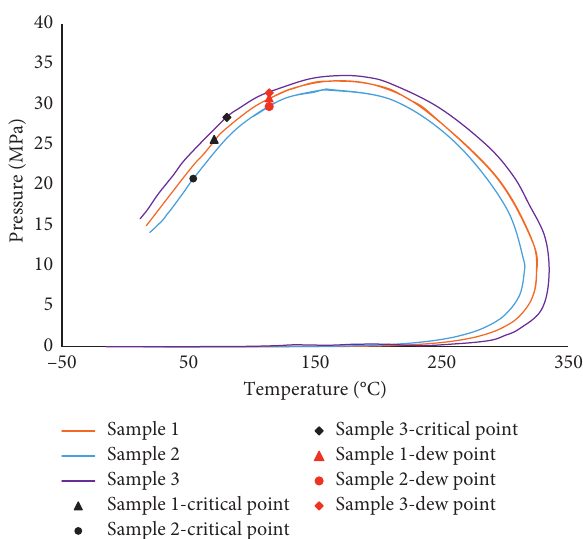
Figure 12: Comparison diagram of P-T phase diagram between sample 1, sample 2, and sample